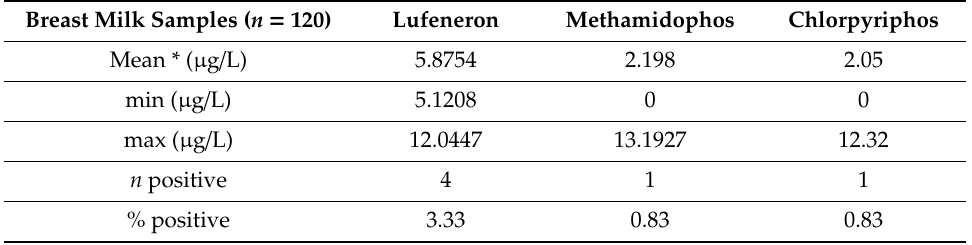
Table 6. Occurrence in the 120 breast milk samples of lufeneron, methamidophos and chlorpyriphos. Breast Milk Samples ( n =